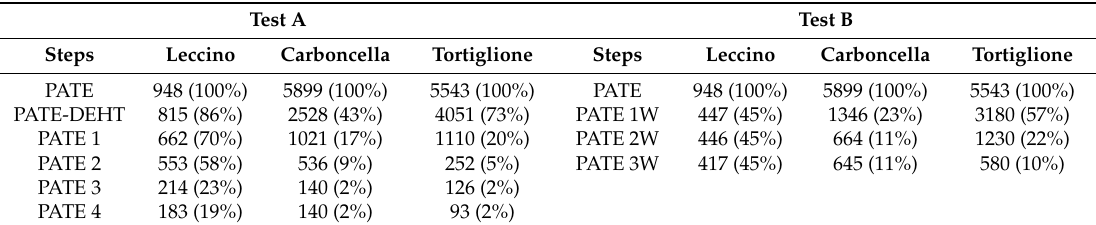
Table 3. Comparison of degradation rate of total phenolic compounds during test A and test B. Data are expressed as total biophenol content mg / kg of DMF p â t é and, between parenthesis, the remaining percentage of total biophenols.